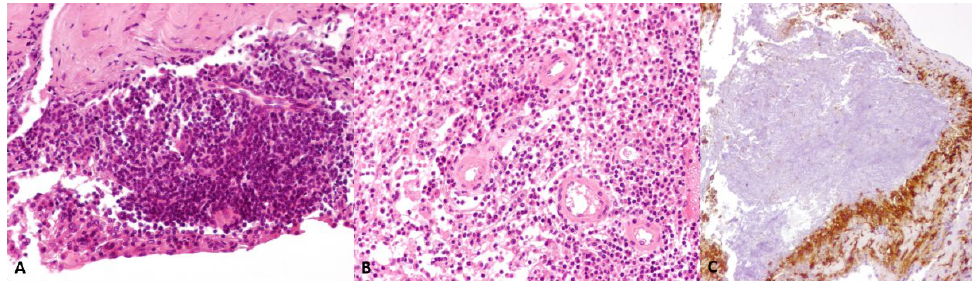
Figure 2. ( A ): meningeal tissue showed thickening, fibrosis, focal meningothelial hyperplasia, and inflammatory infiltration, with scattered epithelioid cells (H&E, 200× magnification). ( B ): the florid inflammation consisted predominantly of lymphocytes and plasma cells (H&E, 200× magnification). ( C ): necrotizing granulomas containing debris of neutrophils were delimited by numerous CD68 immunostained histiocytes and epithelioid cells (200× magnification). Table 1. Cerebrospinal fluid parameters in Case 1 and Case 2.